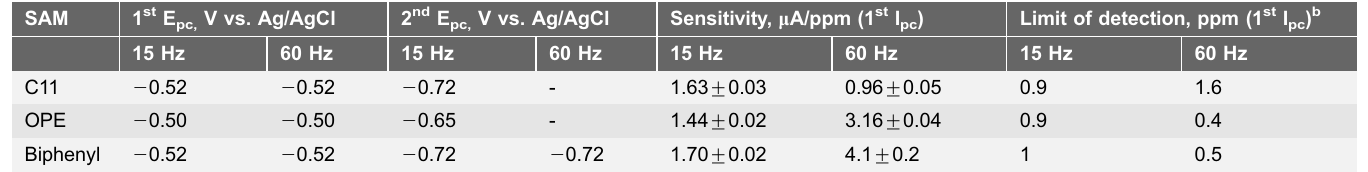
Table 2. Electrochemical experimental data for the reduction of TNT a . SAM 1 st E pc, V vs. Ag/AgCl